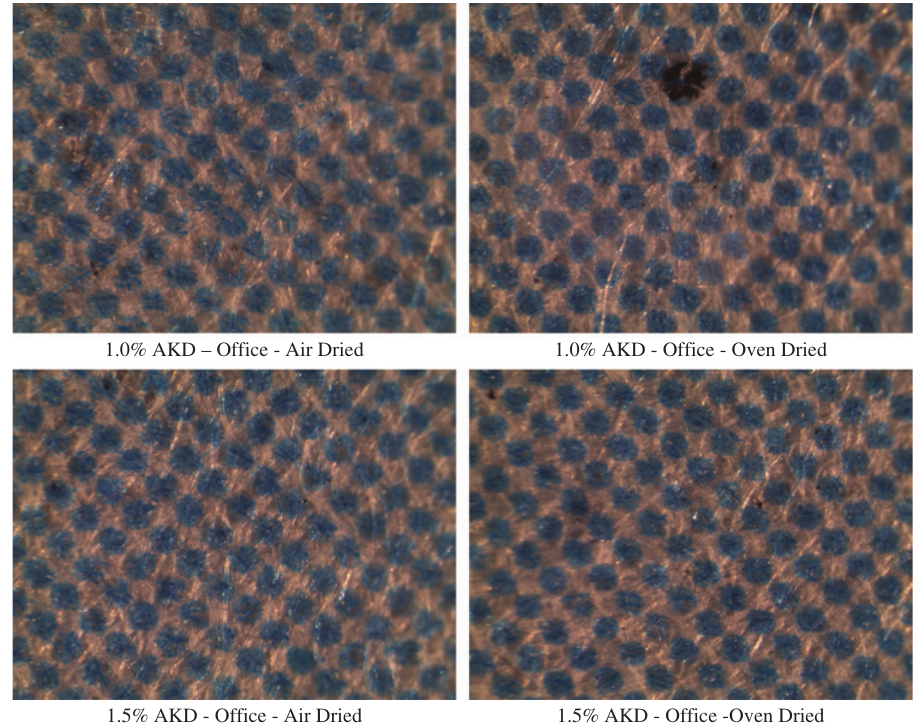
Figure 7: Magnified ( × 50) images of screen dots (80%) on the offset printed of office papers.